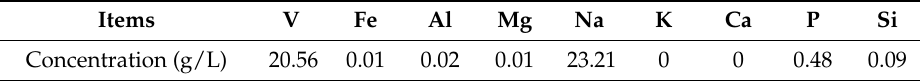
Table 4. Main chemical composition of desorption V (V) solution.